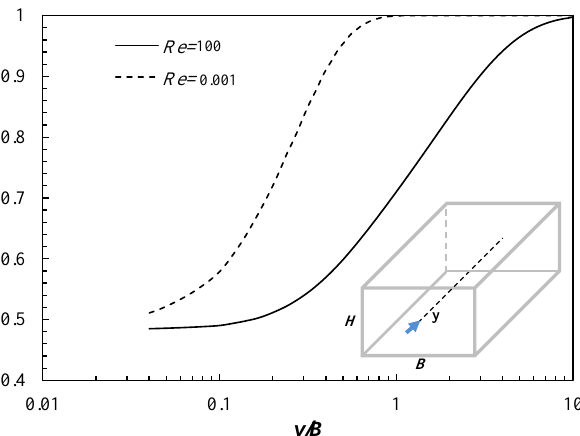
Figure 5. Axial velocity development along the y − axis in the centerline ( x = 0, z = 0 ) for AR = 1 and Re = { 0.001,100 }